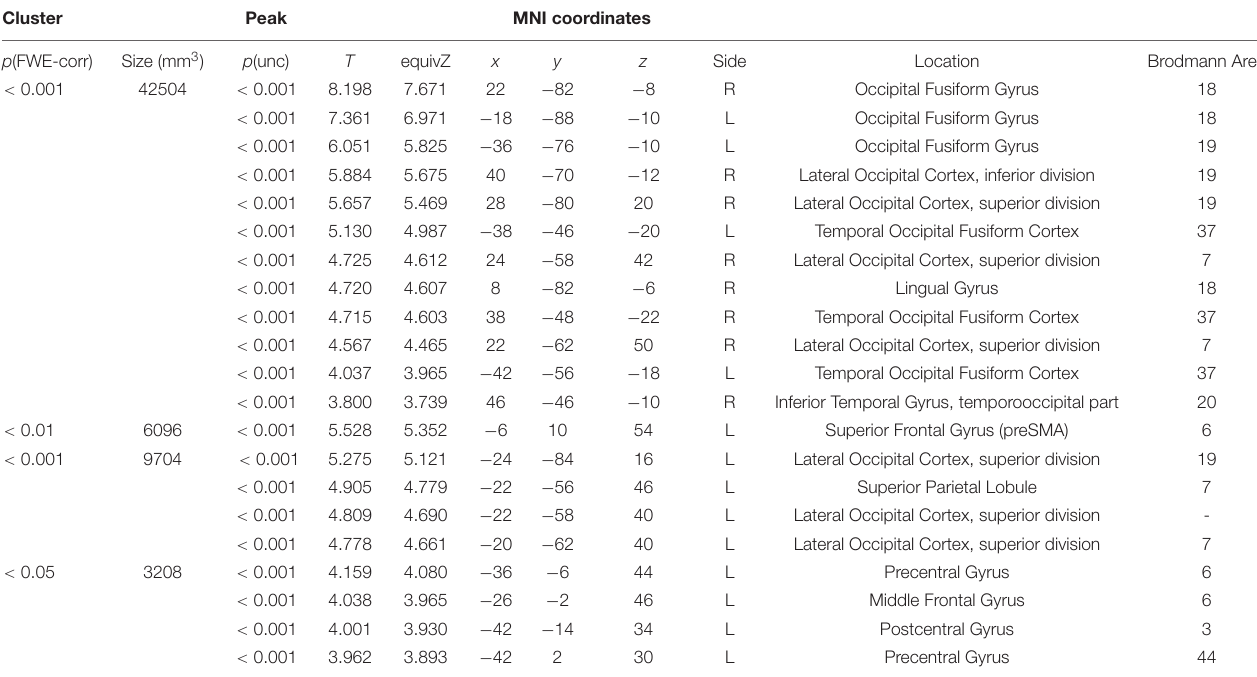
TABLE 2 | The regions showing repetition suppression of cross-structural priming, excluding the effect of N priming (conjunction of [dP < nP] + [nN < dN] and [pD < nD] + [nN < pN]). Cluster Peak MNI coordinates p (FWE-corr) Size (mm 3 ) Location Brodmann Area < 0.001